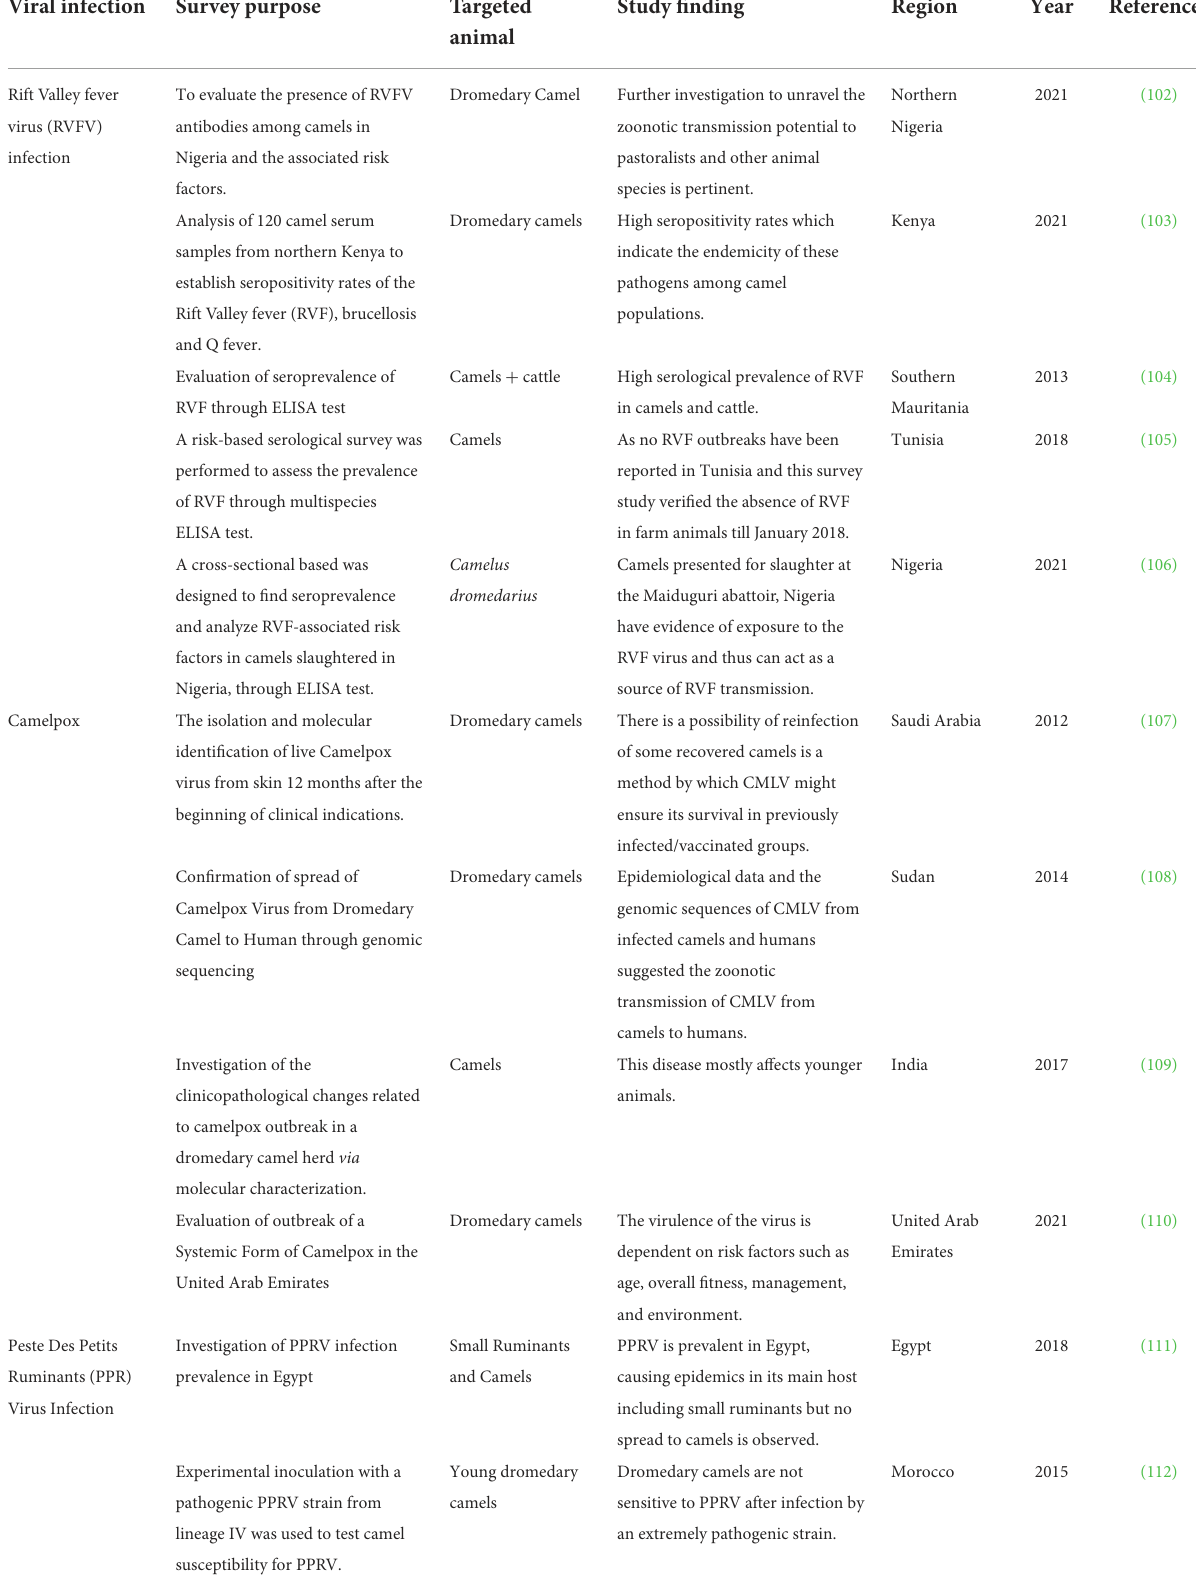
TABLE 1 Summary of screening surveys conducted to evaluate the seroprevalence of various viruses in